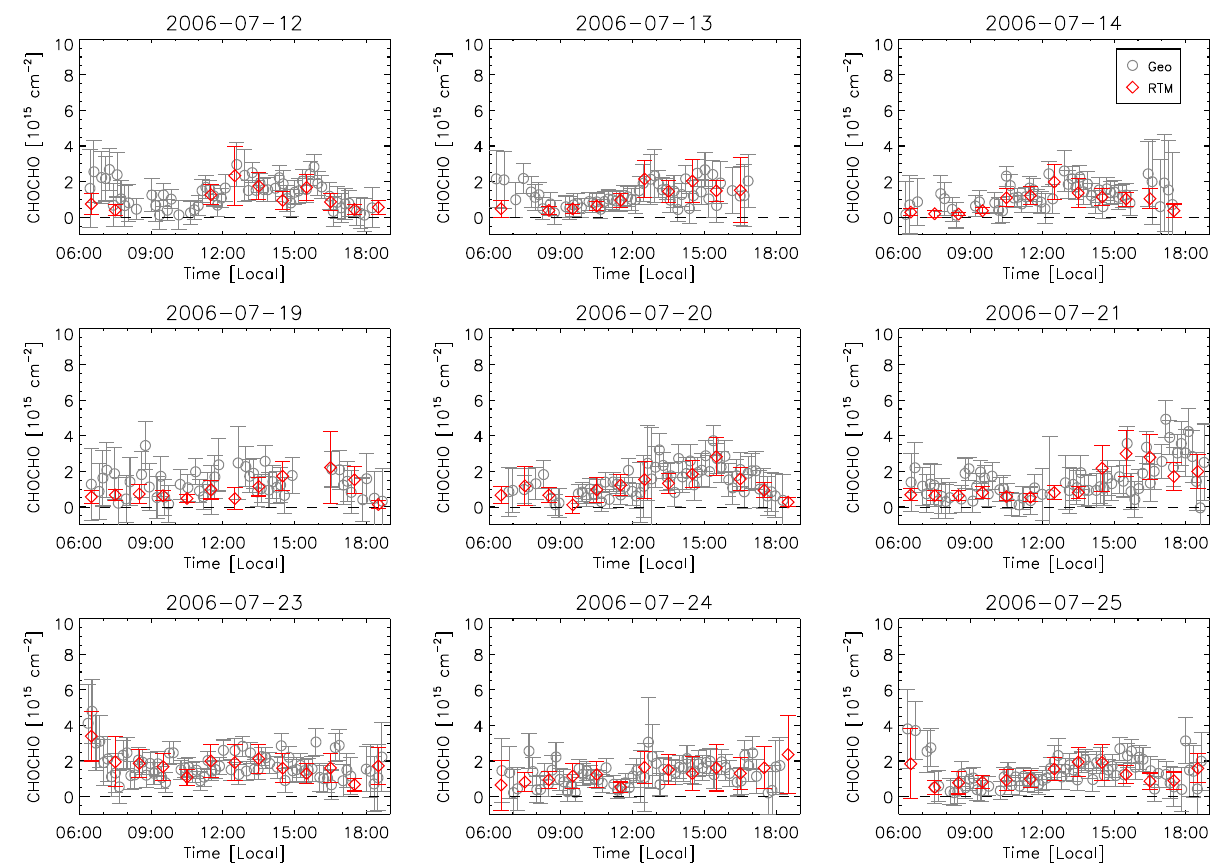
Fig. 5. Time series of CHOCHO vertical column densities (VCDs) on the 9 cloud-free days during the PRIDE-PRD2006 campaign. The grey circles represent CHOCHO VCDs calculated by the geometric approach (i.e. Eq. 1), and the red diamonds refer to CHOCHO VCDs derived from the CHOCHO vertical distribution retrieval (i.e. Fig.